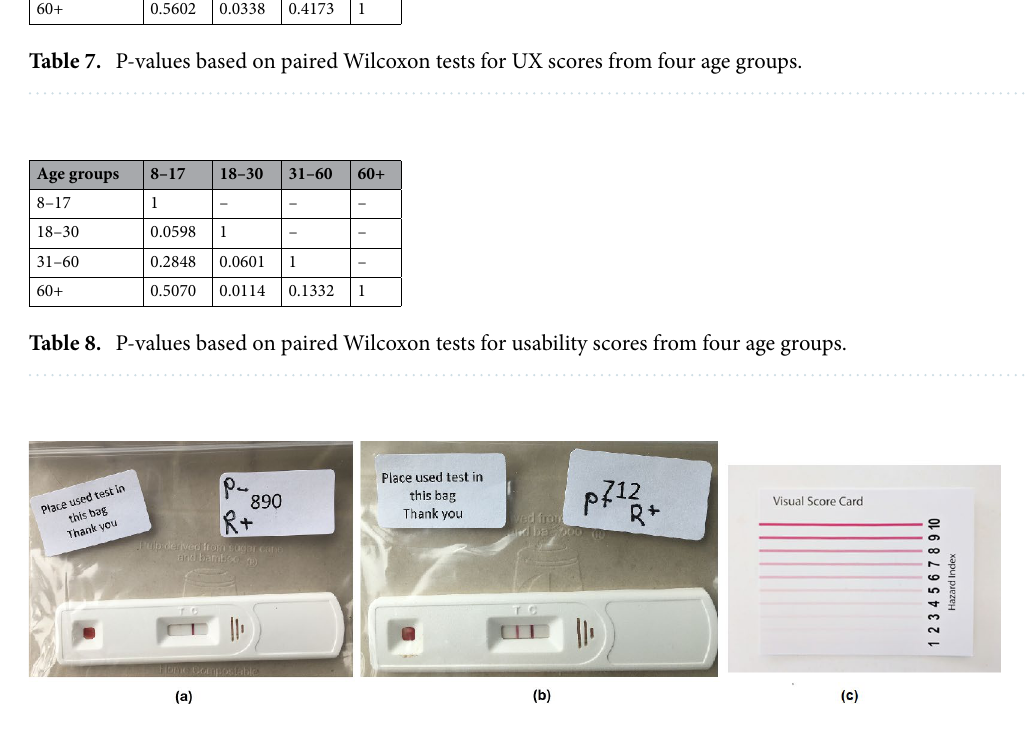
Figure 6. Examples of two test kits placed in the polyester bag (to prevent cross-contamination): ( a ) participant’s result read as negative (P-) and researcher’s was positive (R+); (b) both participant and researcher’s results were positive (P+ and R+); ( c ) a visual score card for